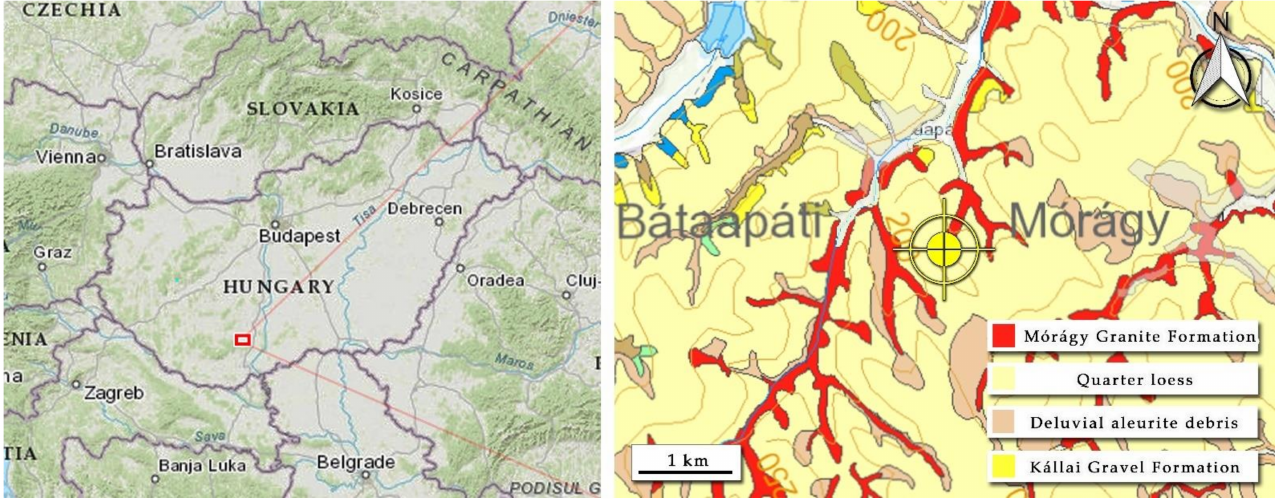
Figure 1. The location of the B á taap á ti Nuclear Waste Repository site in Hungary ( left ). Surface geological environment of the area of the repository ( right )